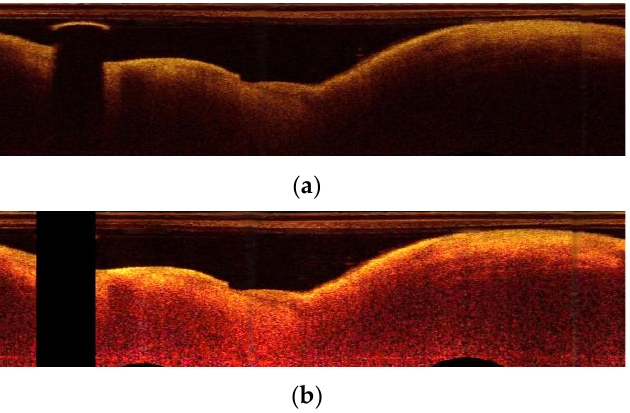
Figure 3. OCT-specific transformations: ( a ) the original image in polar coordinates; ( b ) the image after the transformation based on attenuation coefficient estimation.